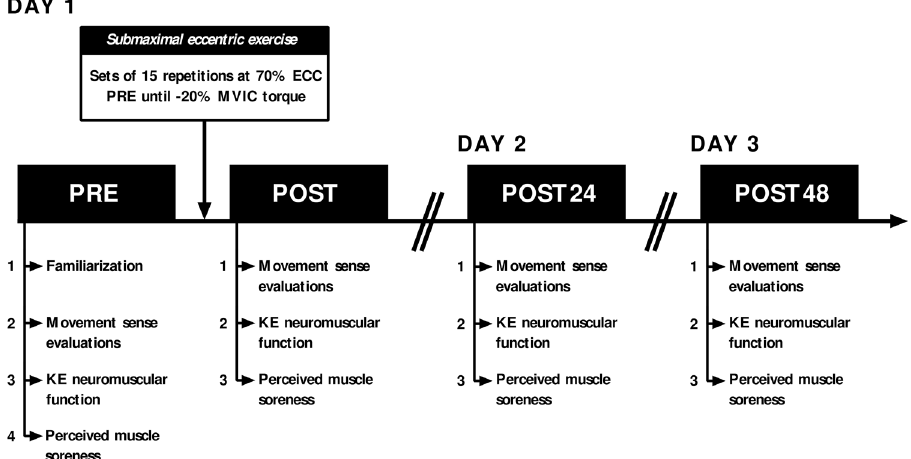
Figure 1. Overview of the experimental protocol. Neuromuscular and psychophysical evaluations were performed before (PRE) and immediately after (POST) a unilateral fatiguing eccentric exercise at the knee. PRE evaluations were similarly performed 24 (POST24) and 48 (POST48) hours after the eccentric exercise, without the familiarization period. Please refer to the text for further explanations. KE Knee extensors , ECC Maximal voluntary eccentric contraction , MVIC Maximal voluntary isometric